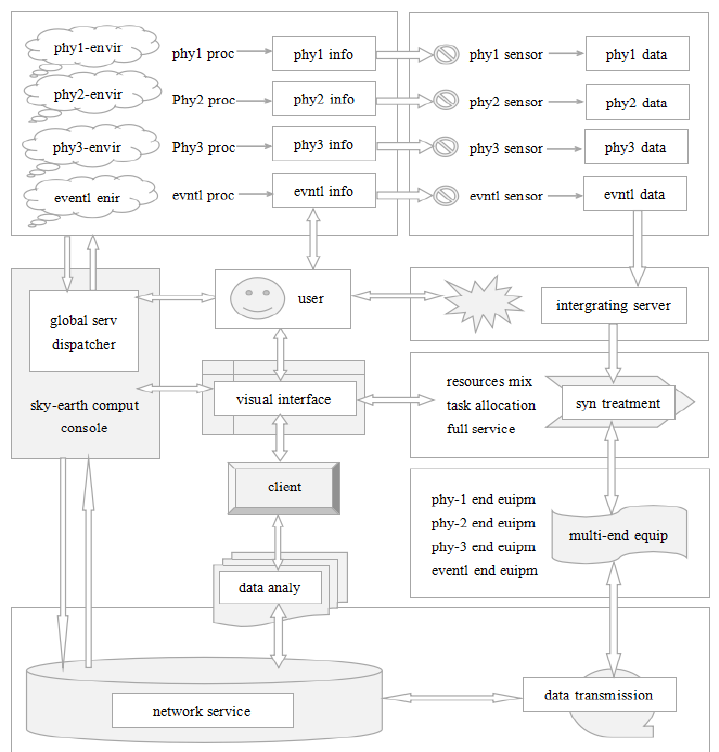
Fig. 3. Super metauniverse system based on sky-earth computing